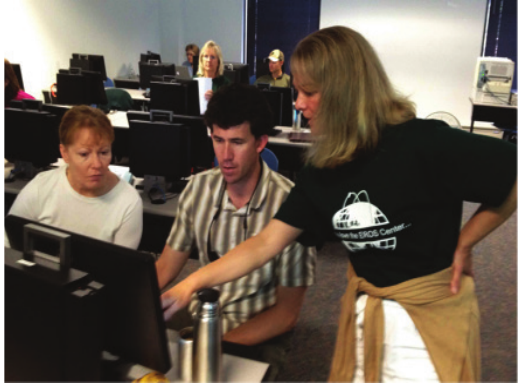
Figure 2b. Members of iGETT Cohort 3 help each other with remote sensing analysis (at